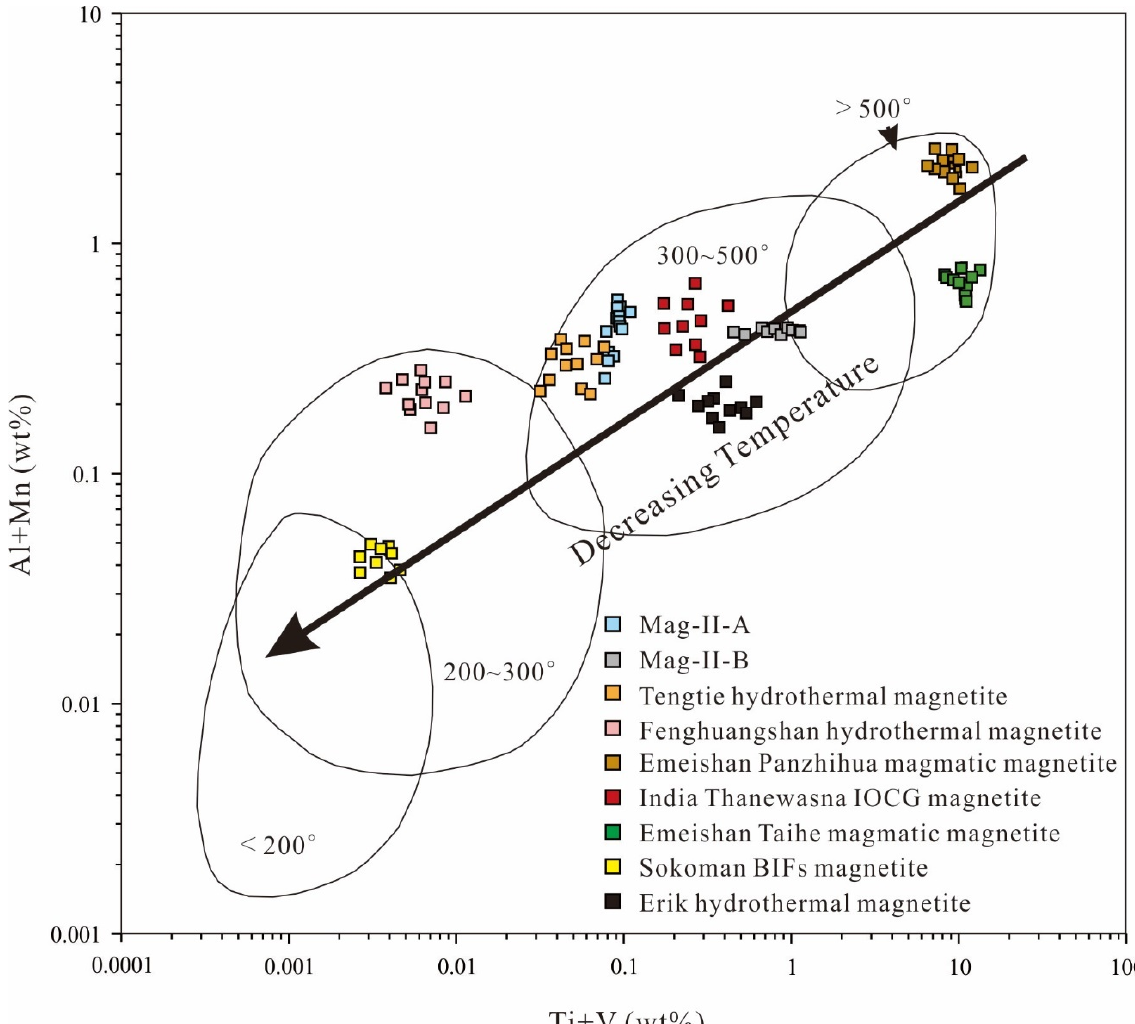
Figure 7. Magnetite (Al + Mn)–(Ti + V) formation temperature diagram (modified after Nadoll et al. [75]). Second, the oxygen fugacity has a significant effect on magnetite composition [83– 85]. Toplis and Corgne [86] determined that under the same magma conditions, as the oxygen fugacity decreases, the V 2 O 3 content in magnetite increases. Additionally, divalent cations such as Ca, Co, Ni, Mn and Mg have no systemic dependence on oxygen fugacity, meaning that the content of V is closely related to the oxygen fugacity (f O2 ). V ion substi- tution generally occurs under low oxygen fugacity conditions. Normally, V mainly exists in magnetite as V 3+ , with only a small amount of V 4+ present, and it is difficult for V to enter magnetite under high oxygen fugacity conditions. Dare et al. [62] studied the Bush- veld laminated Fe-Ti-V deposit and found that magnetite with a higher V content gener- ally crystallized in the early stage, with a lower oxygen fugacity in the early stage, mean- ing that conditions were favorable for V to enter the magnetite, while the magnetite formed in the late stage of magmatic differentiation had a higher oxygen fugacity and was generally poor in V. The V content of Mag-II-A and Mag-II-B (16.1–21.4 ppm and 80.5– 95.7 ppm, respectively) is two orders of magnitude different from that of typical magmatic magnetite such as Emeishan Taihe iron ore magnetite (3465–4250 ppm). However, it is not much different from the hydrothermal origin of IOCG-type deposits such as the magnetite (190–283 ppm) of the Laoshankou Fe-Cu-Au deposit in Xinjiang, which also indicates its hydrothermal origin. The slightly higher V content of Mag-II-B compared to Mag-II-A also indicates that its formation time is earlier. At the same time, elements such as Mg, Ti, V, Cr, Ni and Zn can be used to distinguish the genesis of magnetite from magma and hydrothermal fluid [75]. The Ti content of most